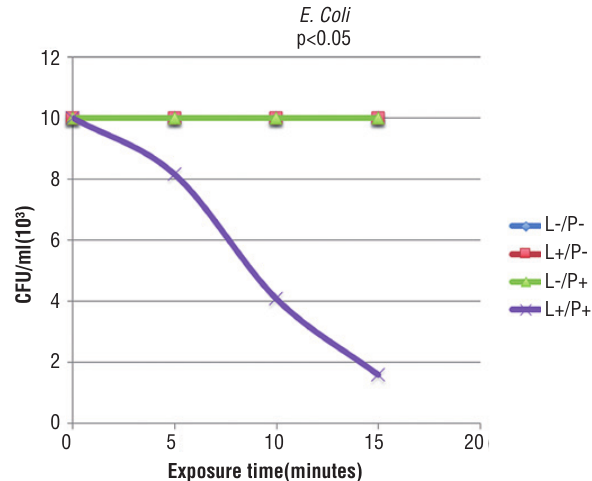
Figure 3 - Mean CFu/mL of E. coli submitted to the following treatments: saline as control (L-/P-), laser and saline (L+/P-), photosensitizer (L-/P+), and laser and photosensitizer (L+/ P+). (Tukey test, p < 0.05).